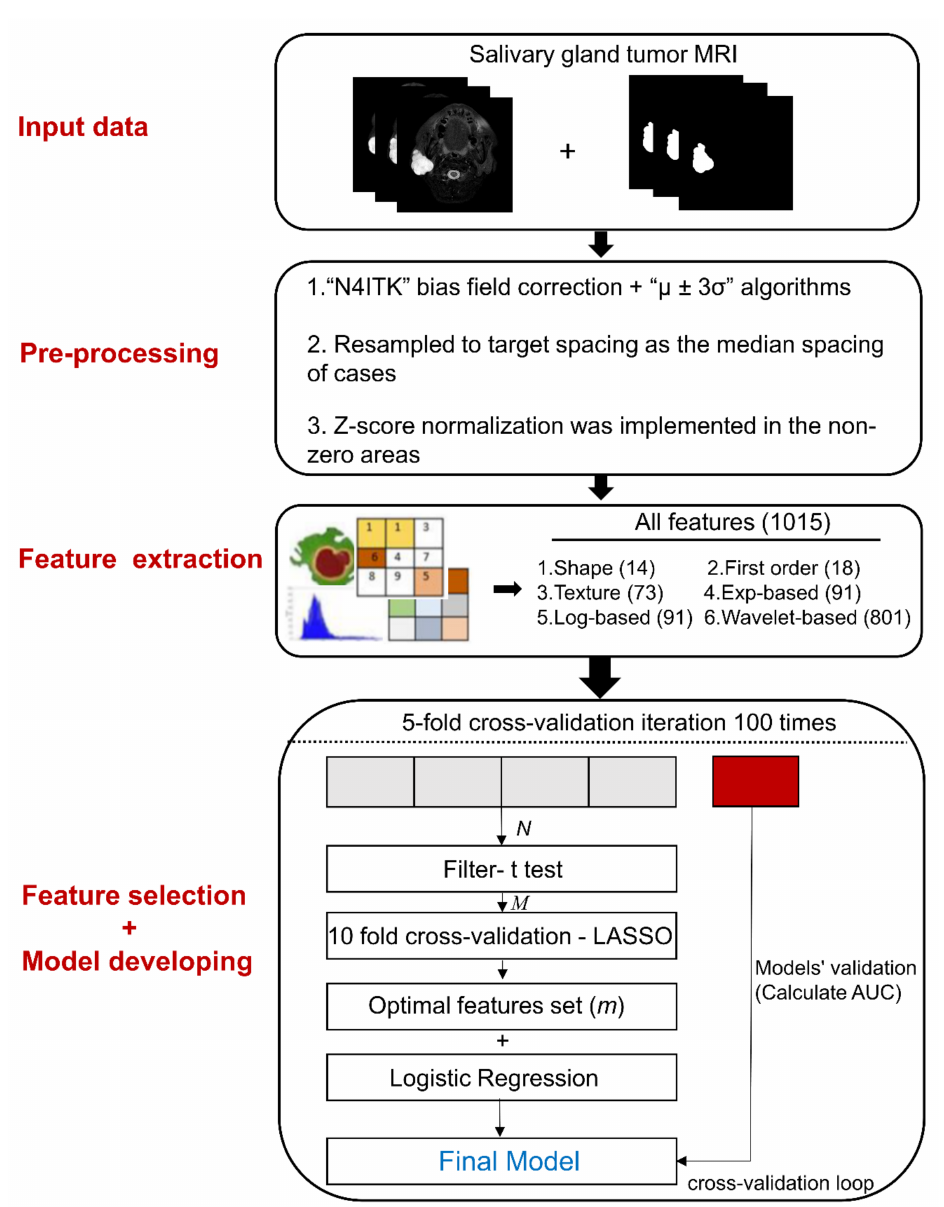
Figure 1. Overview of the radiomic analysis framework to differentiate benign and malignant salivary gland tumors. Region of interest segmentation was performed by experienced clinical